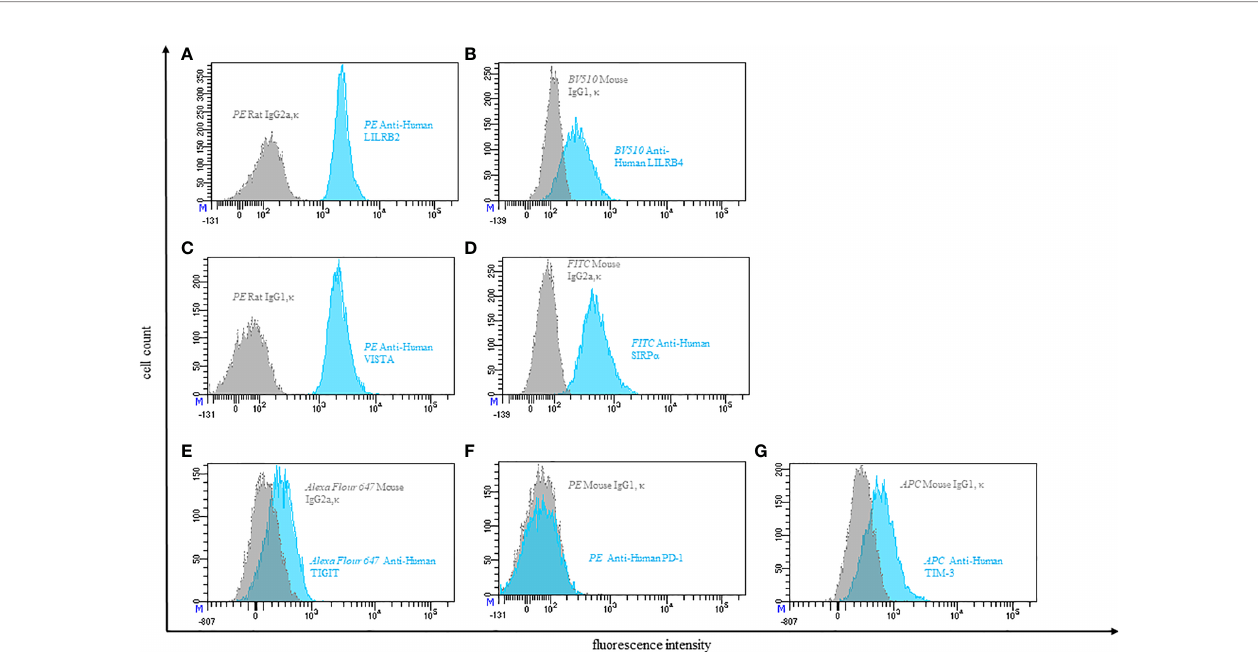
FIGURE 3 | Representative fl ow cytometric analysis of the expression of immune checkpoints (blue): LILRB2 (A) , LILRB4 (B) , VISTA (C) , SIRP a (D) , TIGIT (E) , PD-1 (F) , TIM-3 (G) on resting peripheral blood monocytes of a healthy donor compared with isotype control